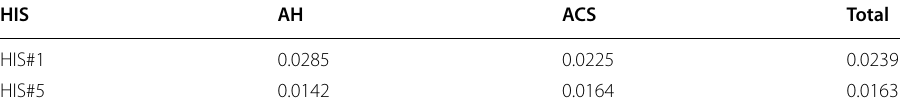
Table 5 Comparison of EHR structure indices by HIS and records with AH and ACS diagnoses